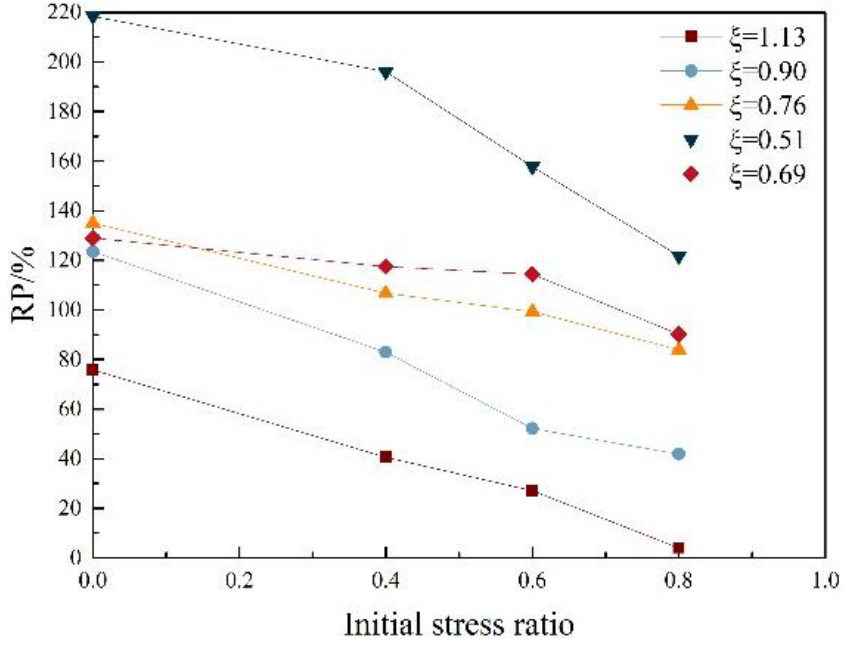
Figure 15. Contribution of